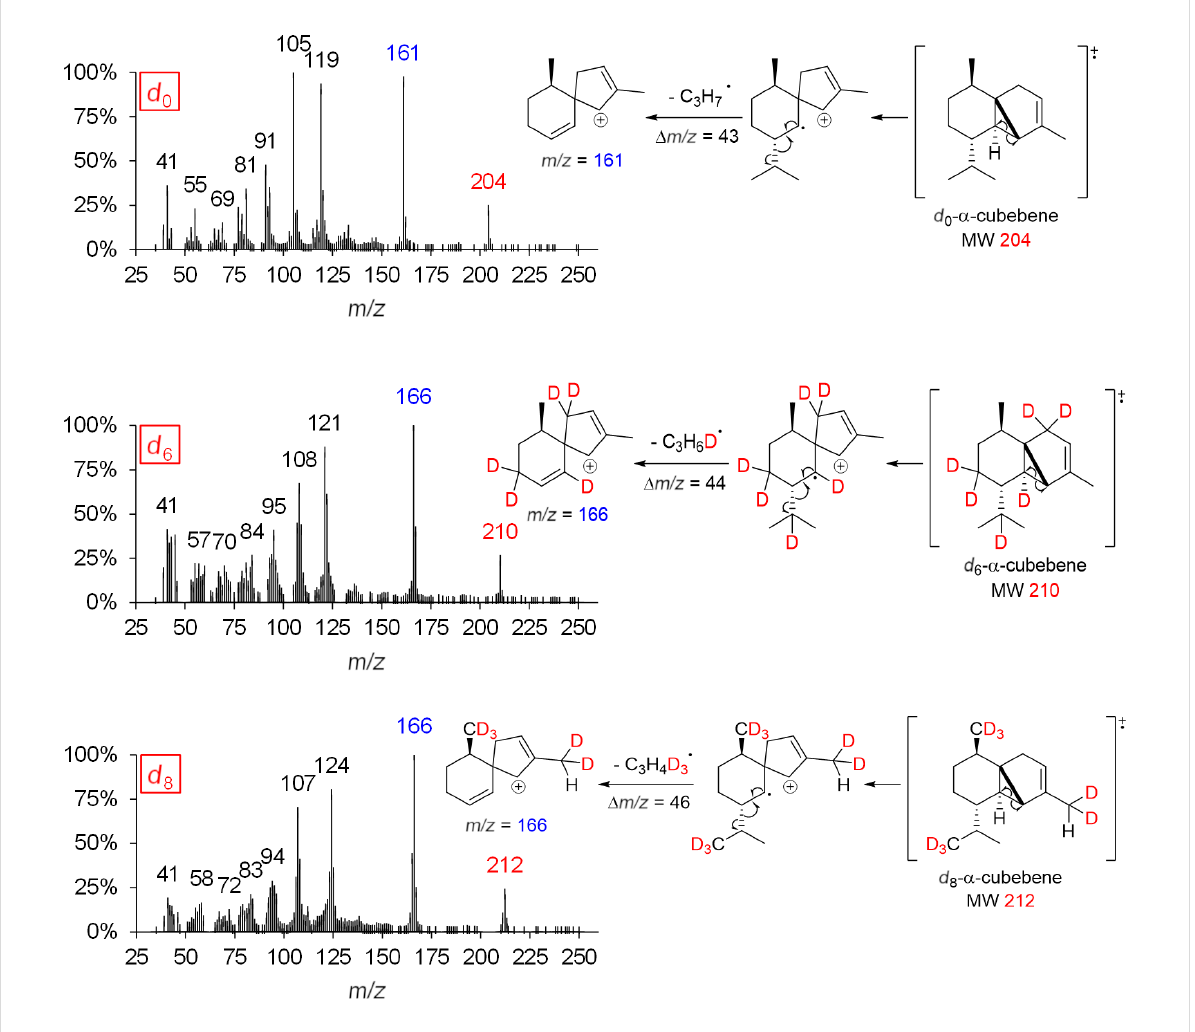
Figure 4: MS spectra of genuine ( d 0 ) and deuterium-labeled ( d 6 and d 8 ) α -cubebene (left panel) after administration of [5,5- 2 H 2 ]-1-deoxy- ᴅ -xylulose ( d 2 -DOX) and [6,6,6- 2 H 3 ]-(±)-mevalonolactone ( d 3 -MVL) to isolated exocarp of grape berries (Lemberger cultivar). Expected labeling patterns are depicted for α -cubebene (right